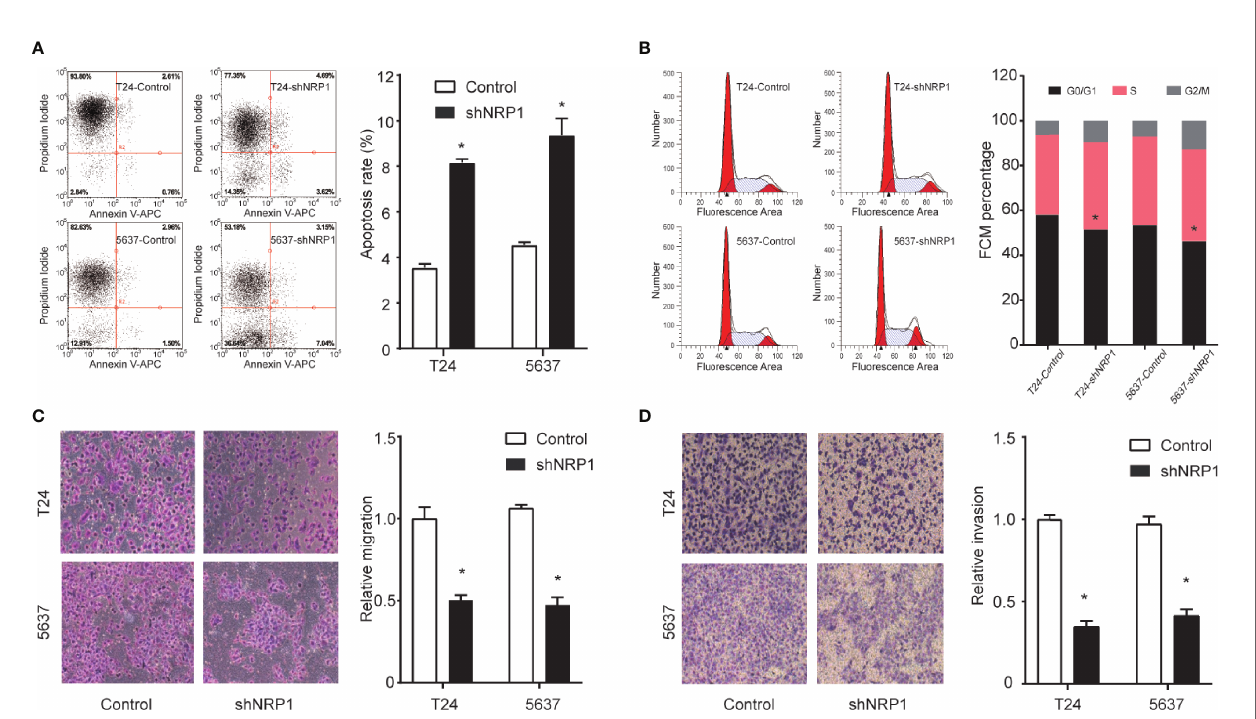
FIGURE 3 | NRP1 modulates BC cells apoptosis, cell cycle, migration, and invasion. (A) Apoptosis assay and quantitation of apoptotic cells of T24 and 5637 cells after NRP1 knockdown or control shRNA expression. (B) Flow cytometric analysis of T24 and 5637 cells following NRP1 knockdown or control shRNA expression. (C, D) Images and normalised migration (C) or invasion (D) of T24 and 5637 cells following NRP1 knockdown or control shRNA expression. Three independent experiments were conducted for each assay, and data are presented as the mean ± standard error of the mean, * p < 0.05 vs . the control